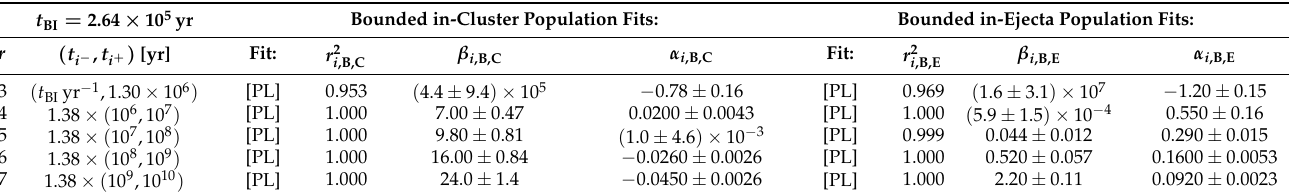
Table 7. Mean bounded in-cluster and in-ejecta object population PL fits of Figure 9 from Equation (31): N P ( t ∈ r ) = β i ,P t α i ,P . α i ,P is the PL index, again corresponding to the constant level of the differential counts, while β i ,P , corresponds to the amplitude of the PL, r = 3, . . . ,7 refers to the separate run where the fit is performed and P = ( R,C ) , ( R,E ) denotes the bounded cluster and ejecta populations, respectively.